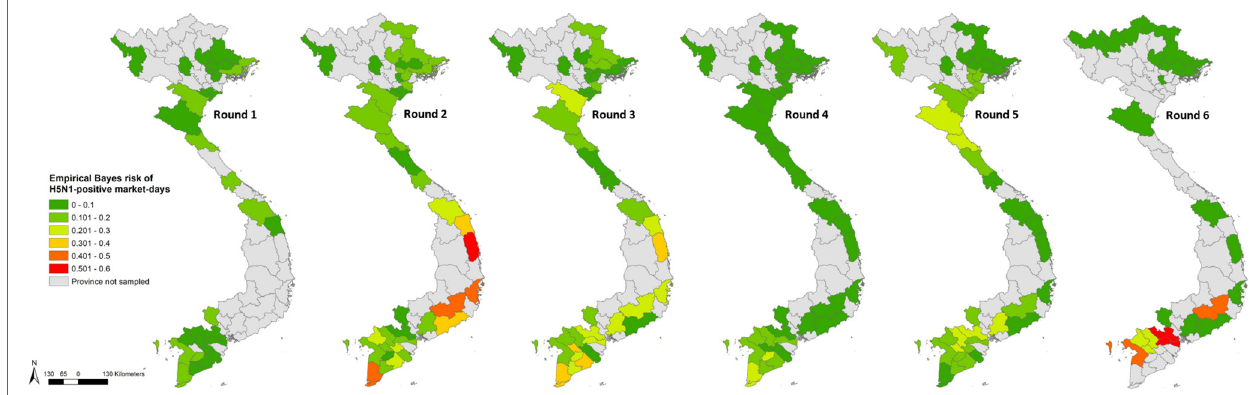
FigUre 1 | Province-level Bayes risk of highly pathogenic avian influenza H5N1 in Vietnam (Rounds